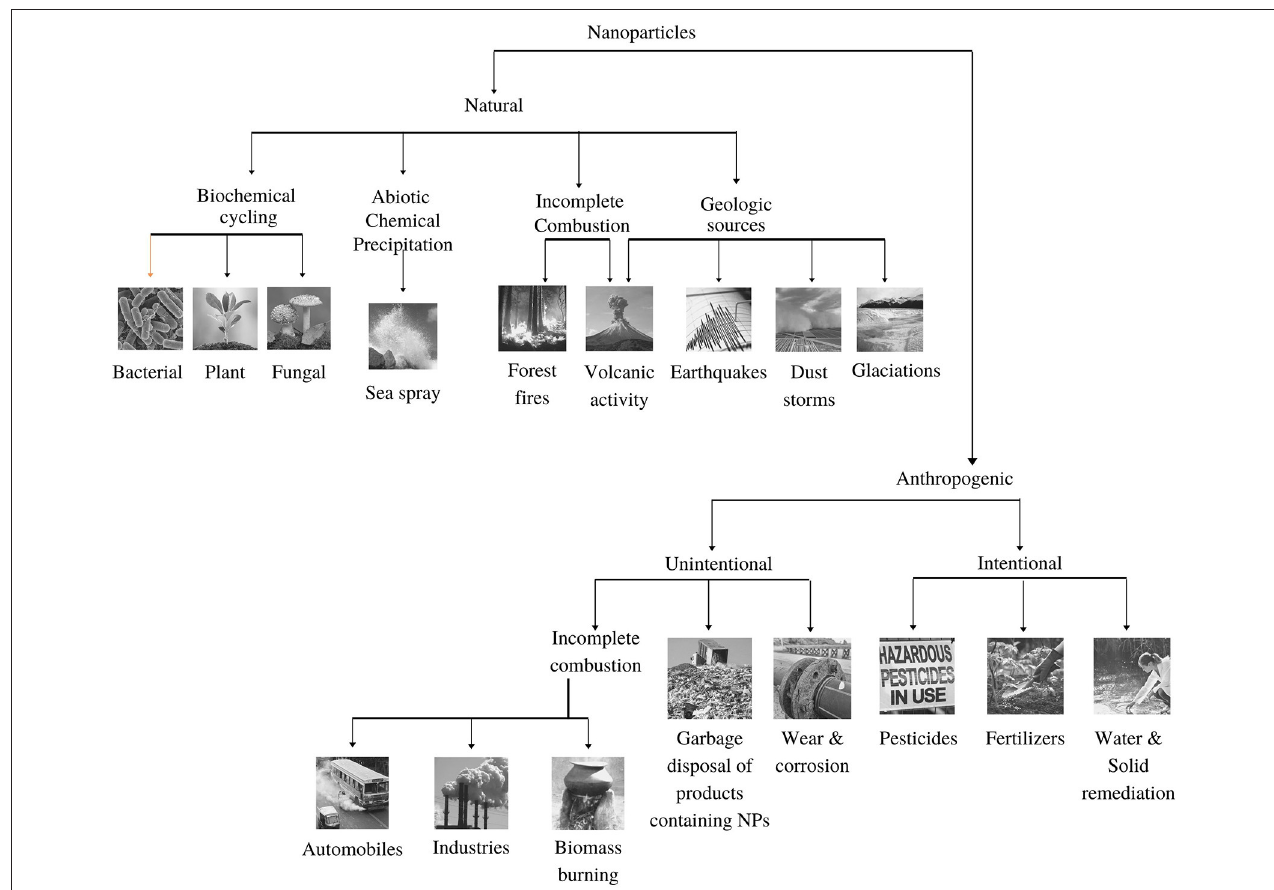
FIGURE 1 | Emission sources (Natural and anthropogenic) of nanoparticles in the environment (adopted from Buzea and Pacheco,